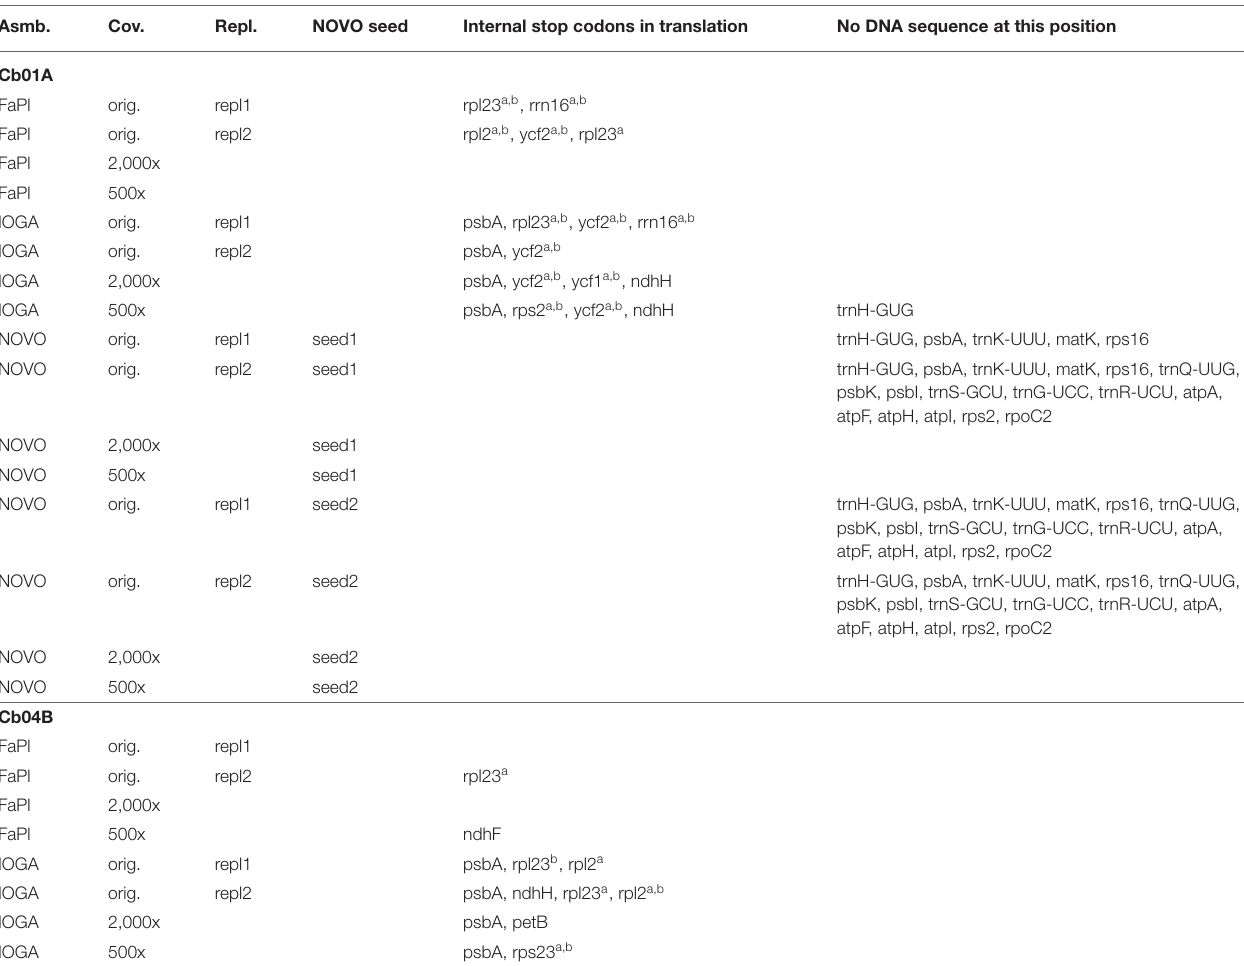
TABLE 3 | Overview of incorrect or missing annotations among the plastid genome assemblies of C. bakuense as generated under different assembly software, sequencing coverage, seed sequences, and run replicates.